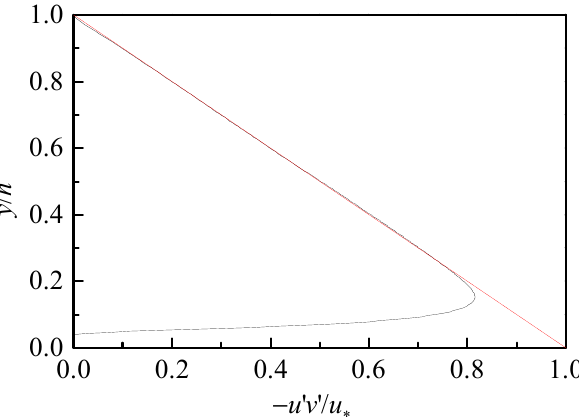
Figure 3. Reynolds shear stress normalized by the bed shear velocity. The black solid line represents Reynolds shear stress − u (cid:48) v (cid:48) / u 2 ∗ on the rough bed; the red solid line represents total shear stress on the smooth bed.